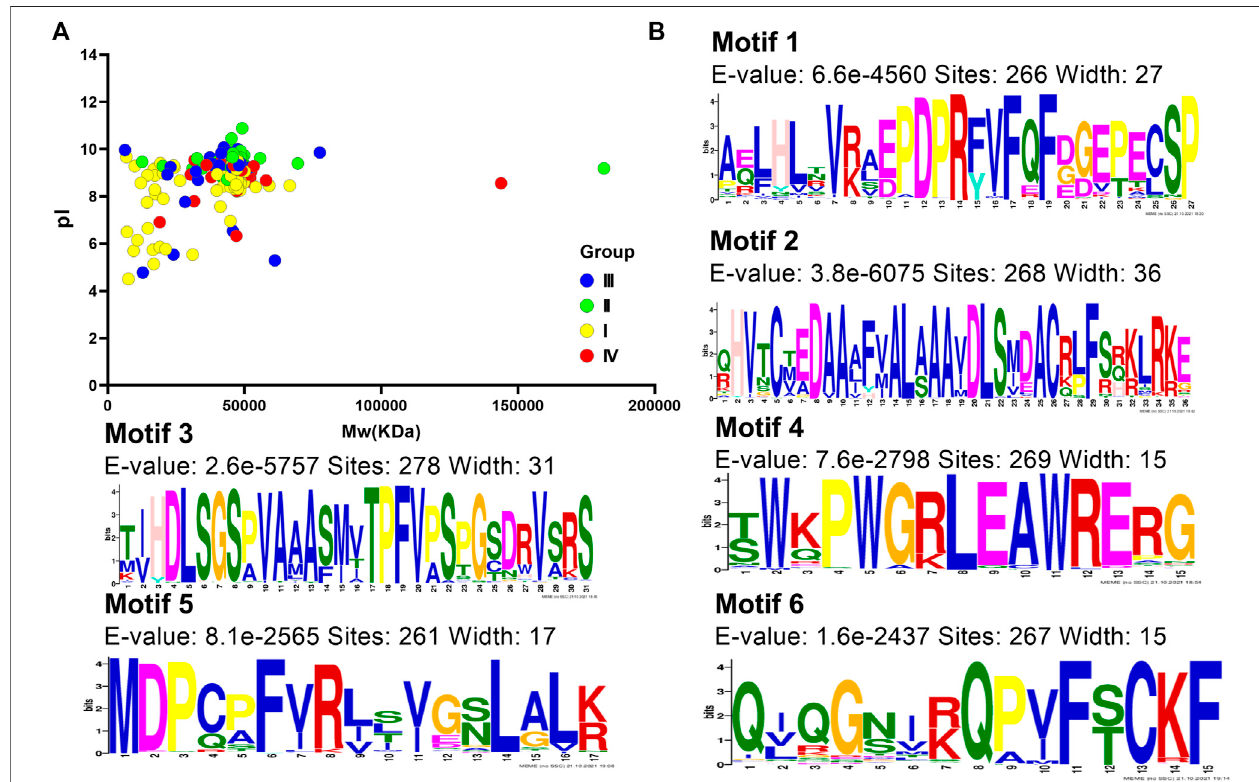
FIGURE 3 | DUF1005 protein features. (A) Molecular weight (Mw) and isoelectric point (pI) of DUF1005 genes in plants. The yellow color represents Group I, the green color represents Group II, the red color represents Group III, and the blue color represents Group IV. (B) Sequence logos for the conserved motifs of DUF1005 proteins in